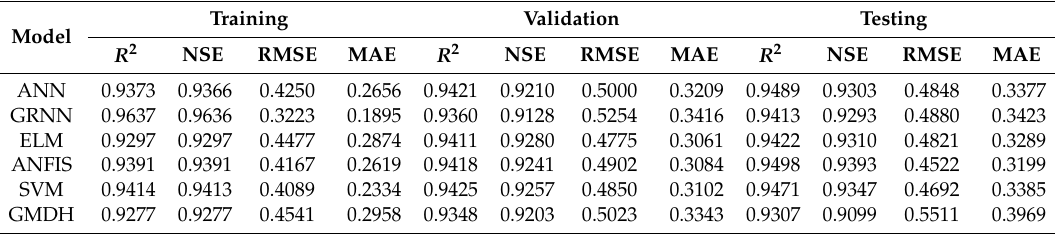
Table 4. Comparisons of data-driven models for ecosystem respiration ( R , g · C · m − 2 · Day − 1 ) for the training, validation and testing periods.